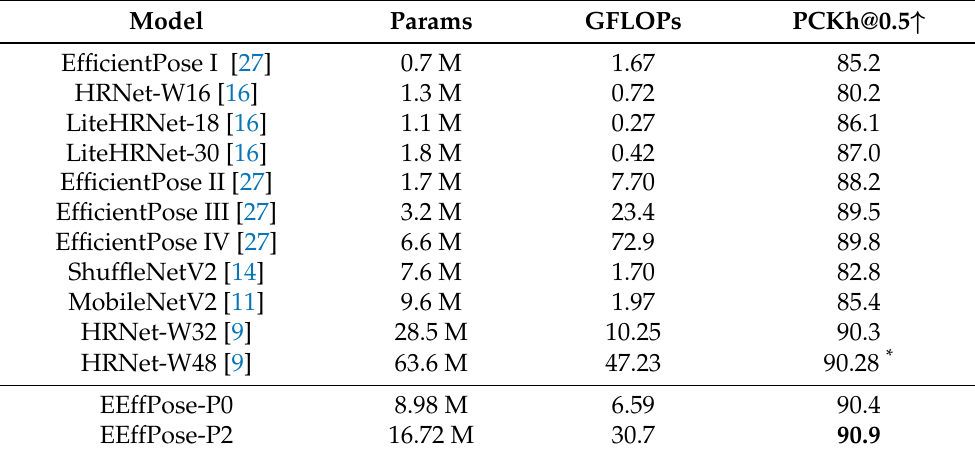
Table 4. Comparisons to the state-of-the-art on the MPII val